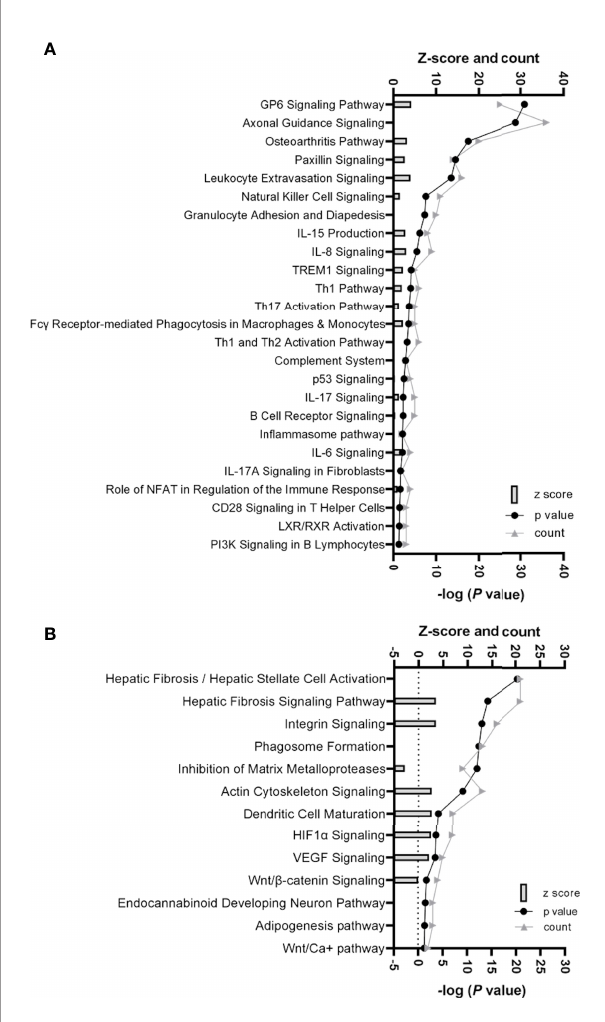
FIGURE 2 | (A) Histogram of 25 signi fi cantly enriched canonical pathways involved in in fl ammation and immune response in scWAT in individuals living with obesity. (B) Histogram of signi fi cantly enriched canonical pathways involved in tissue remodelling and expansion in scWAT in individuals living with obesity. (A, B) The left y-axis represents the z-score (predicted score of activation/ inhibition) and the number of genes counted for each of the representative canonical pathways, and the right y-axis represents -log (P-value), signi fi cance is deemed -log P> 1.3. Where z-score is not present, there was not enough evidence from current literature to determine if the altered gene expression is likely to result in activation or inhibition of a canonical